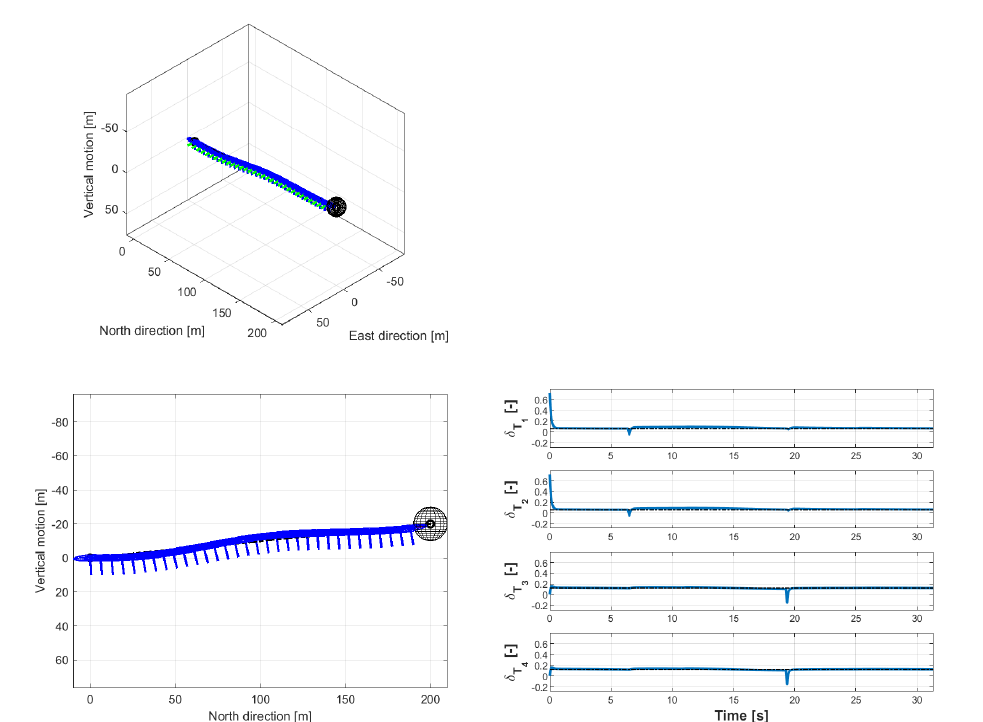
Figure 12. Trajectory and control behavior for an ascending track, as flown by the thrust-controlled, four-thrusters stabilized platform, with the proposed guidance control system. Ground speed setting 6 m/s. ( Top-left ) three-quarter view of the 3D trajectory from the northeast. ( Bottom-left ) view of the trajectory from the east. Black dash-dotted lines: target track. Black spheres: target checkpoint capture volume. ( Bottom-right ) time histories of controls. Black dash-dotted lines: trimmed